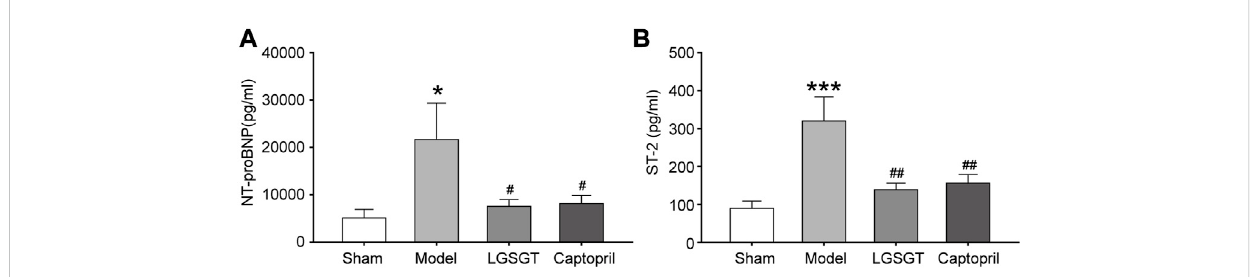
Linggui Zhugan Decoction reduces the level of myocardial markers (NT-proBNP and sST2) in rats with chronic heart failure after myocardial infarction. The levels of biomarker NT-proBNP and sST2 in rats with heart failure detected by ELISA ( n = 7) (A, B) . * p < 0.05 vs. sham group; ** p < 0.01 vs.